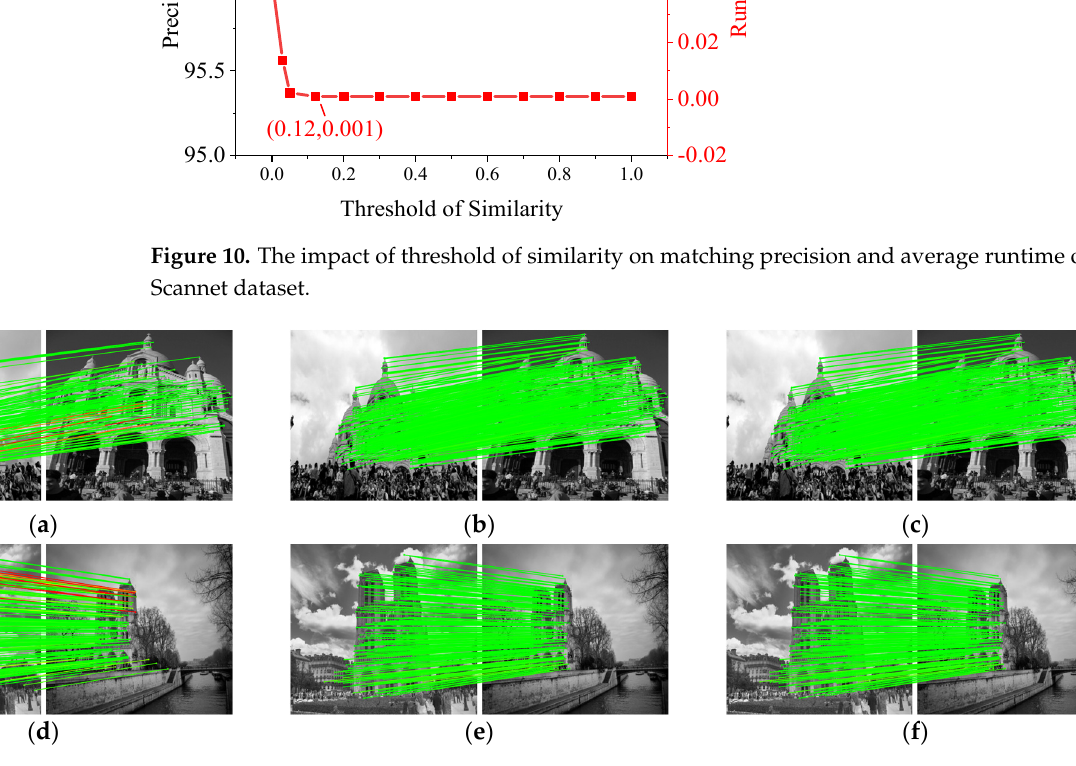
Figure 10. The impact of threshold of similarity on matching precision and average runtime on the Scannet dataset.